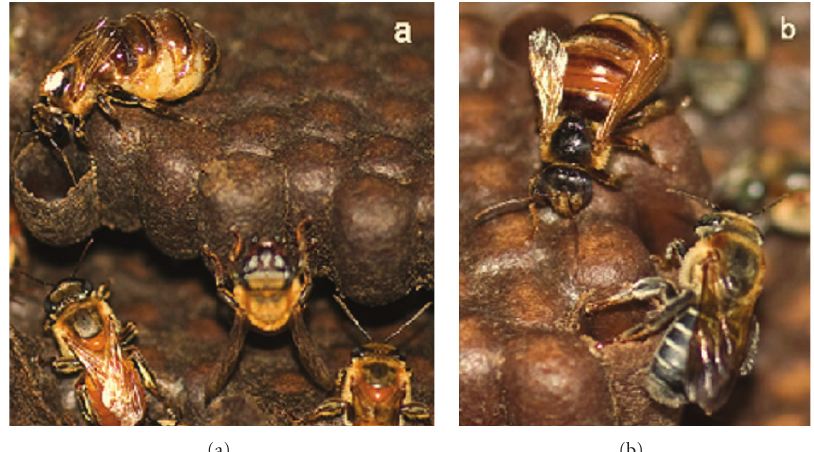
Figure 1: Melipona seminigra merrillae (a) showing the queen marked on the pronotum and workers showing the characteristic color of the scutellum in this subspecies; Melipona interrupta manaosensis (b) queen and worker characteristic colorations.